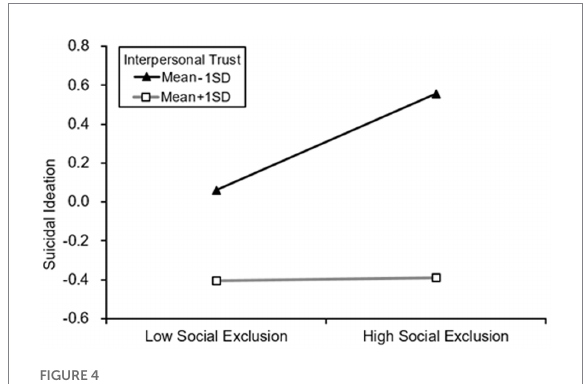
FIGURE 4 Interpersonal trust moderated the relationship between social exclusion on suicidal